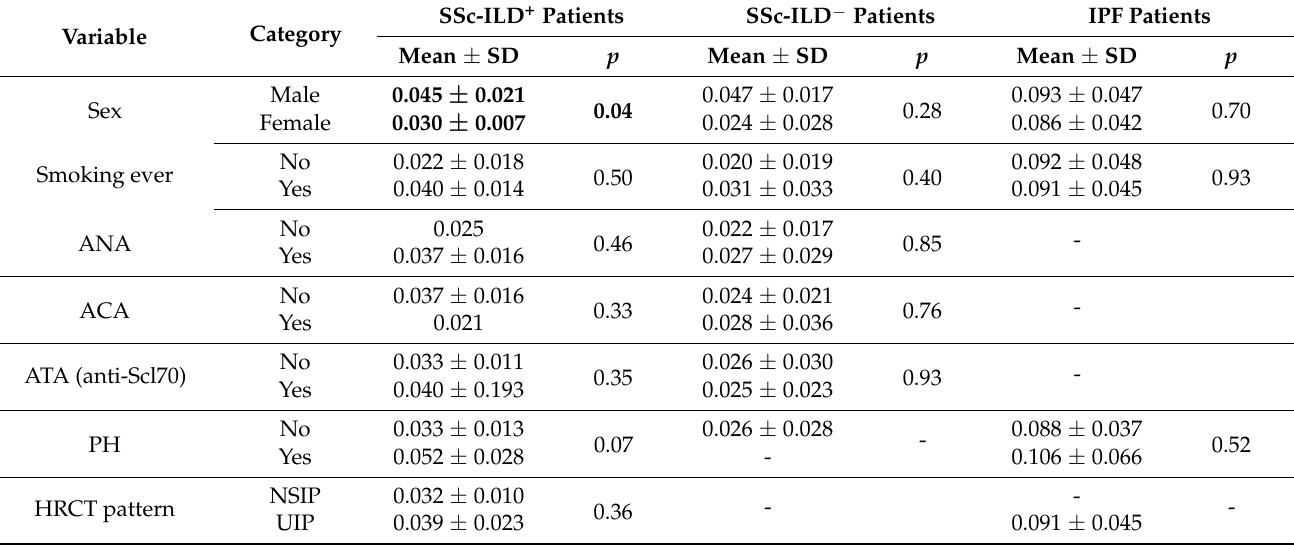
Table 3. Differences in EPC frequency according to categorical variables related to demographic and disease features.